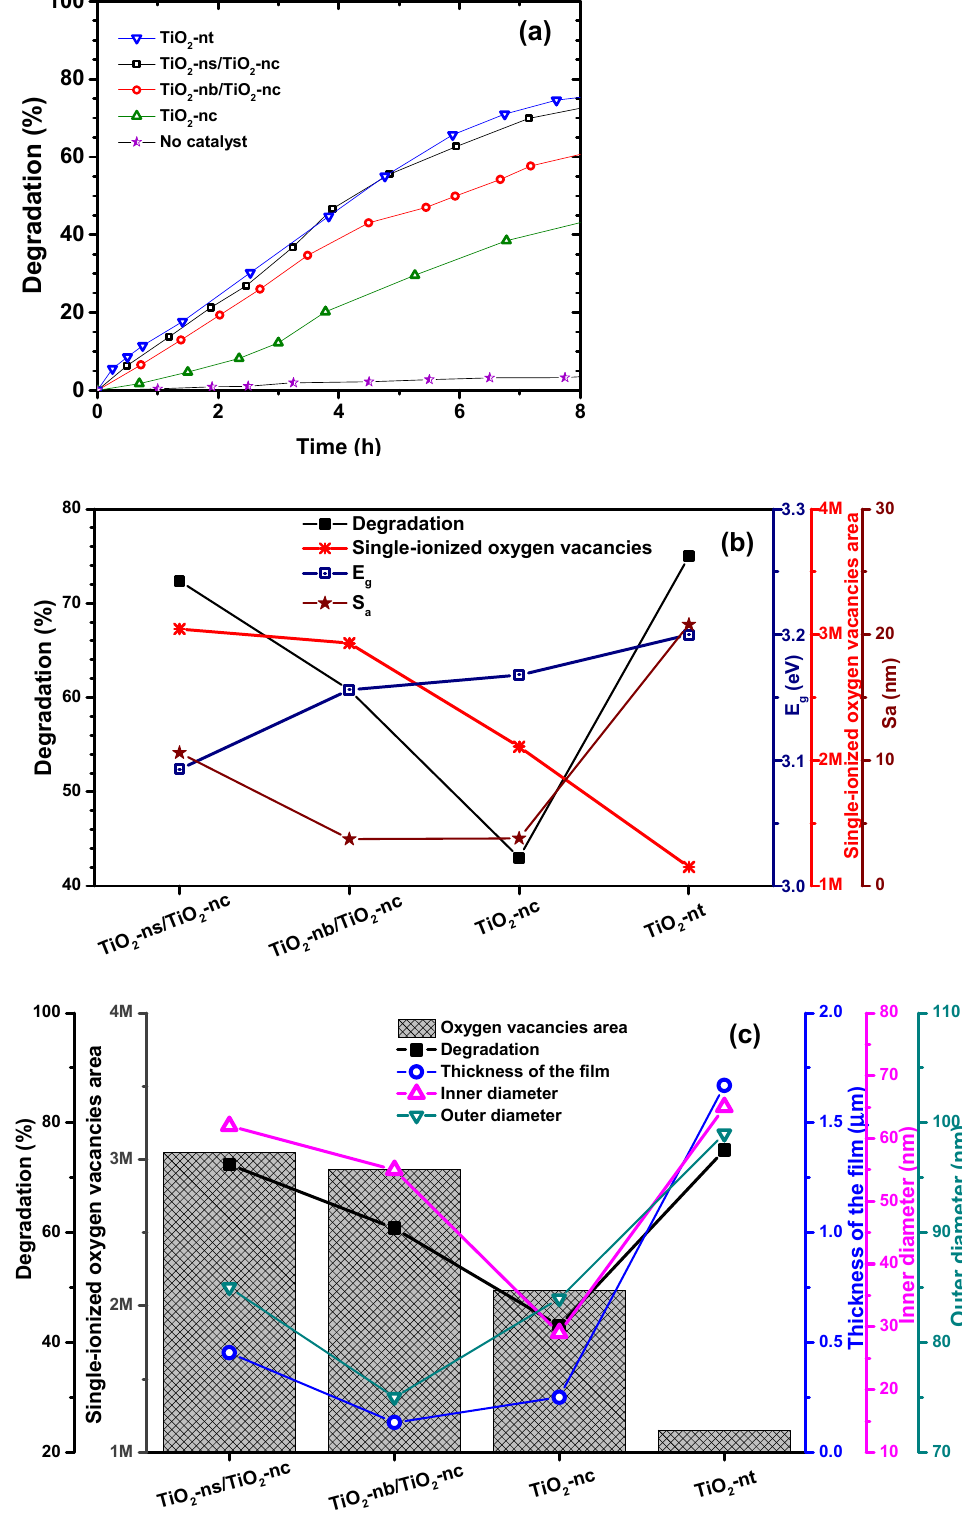
Figure 7. ( a ) percentage of degradation of methylene blue as a function of time for the four nanostruc- tures; ( b ) comparison of defect sates, band gap energy, S a and final degradation percentage between the four films; and ( c ) comparison of geometric parameters, final degradation percentage and oxygen vacancies between the four